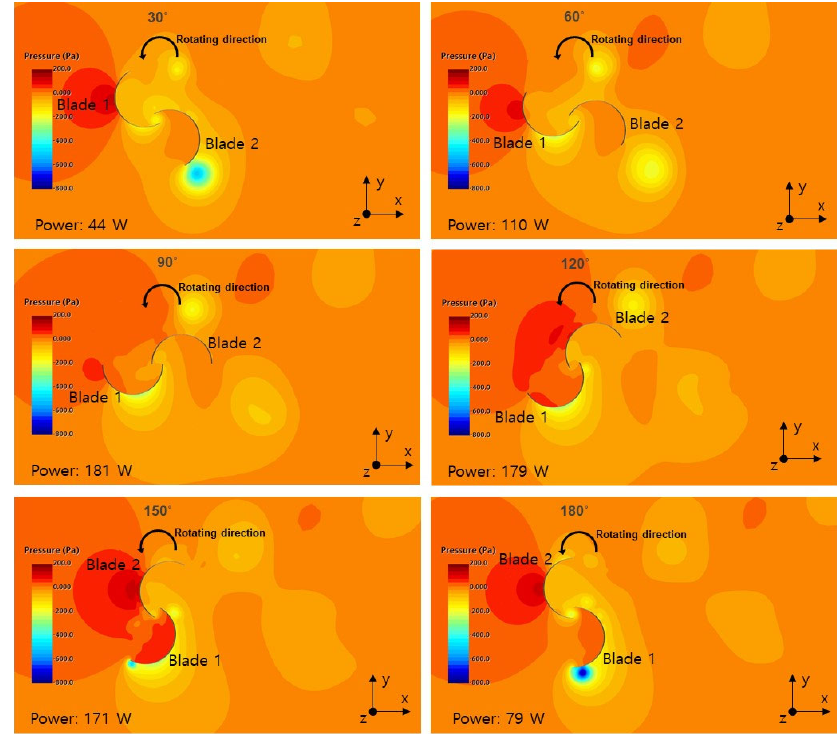
Figure 11. Pressure distribution according to rotor rotation position.